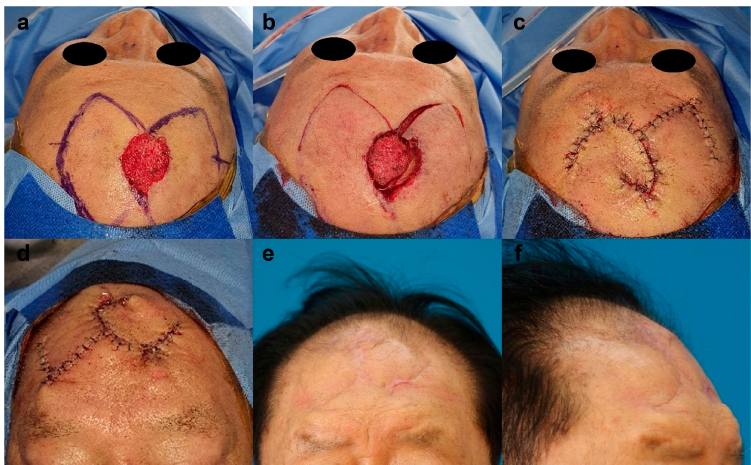
Figure 4. Clinical photographs of case 7. ( a ) Skin defect (3.5 cm × 4 cm) in the frontal scalp, and design of double-opposing hemi-keystone perforator island flaps (KPIFs) (4.5 cm × 4.5 cm and 4.5 cm × 4.5 cm) from the frontal scalp and lateral forehead. ( b – d ) Successful coverage of the defect with the double-opposing hemi-KPIFs. ( e , f ) Postoperative photographs after a 9-month follow-up.